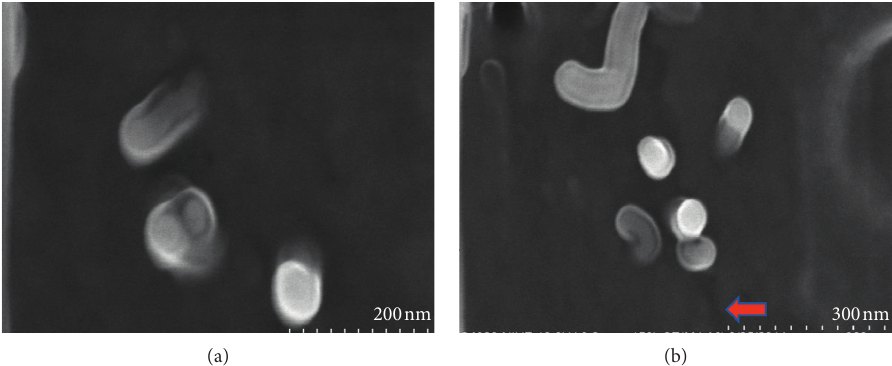
Figure 8: FE-SEM images of nanocomposites fly ash/MWCNTs/epoxy: 40 wt.% fly ash/0.04 wt.% MWCNTs/epoxy ((a), (b)).